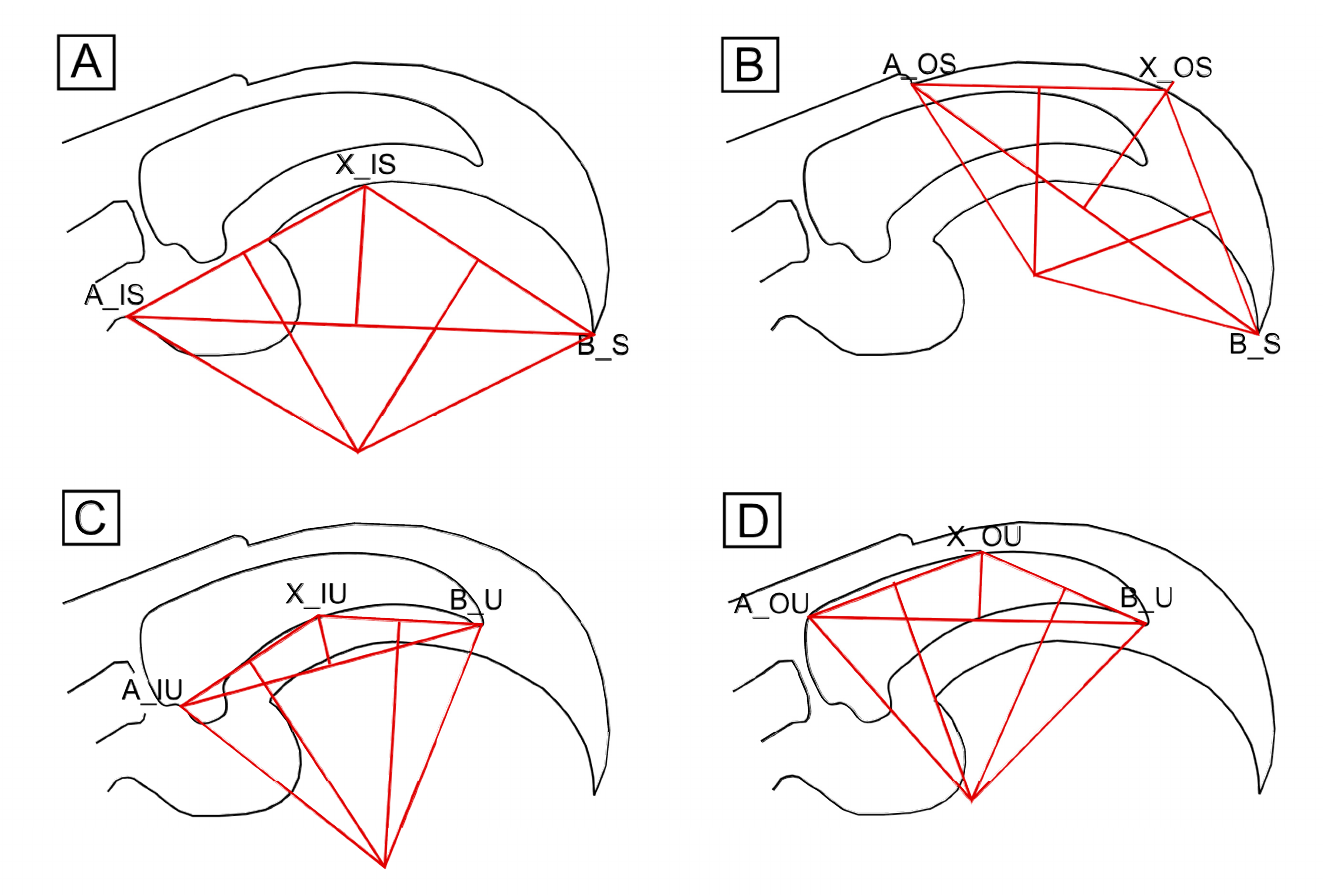
Fig 1. Methods of determining claw angle. Claw drawn in Inkscape. Measurements performed in DinoLino.exe. Landmark A is located at the proximal termination of the dorsal (A_OS) surface of the sheath or ungual bone (A_OU), or the fleshy (A_IS) or bony (A_IU) base of the flexor tubercle. Landmark B is located at the tip of the ungual bone (B_U) or sheath (B_S). Landmark X is drawn at the intersection of � AB � s bisector with the curved surface being measured. (A) Feduccia’s [3] method of quantifying inner curvature of the claw sheath, here denoted IS. (B) Pike and Maitland’s [8] method of quantifying outer curvature of the claw sheath, here denoted OS. (C) A modification of Feduccia’s method to measure inner curvature of the ungual bone, here denoted IU. (D) A modification of Pike and Maitland’s method to measure outer curvature of the ungual bone, here denoted OU.